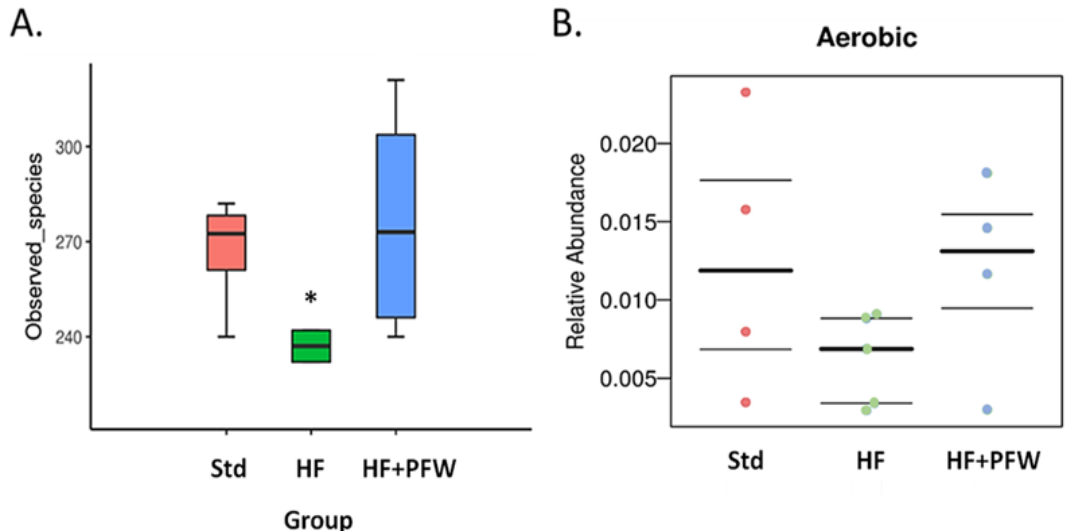
Figure 5. The effect of PFW on gut microbiota composition in high-fat diet-induced mice. ( A ) Alpha diversity index of the gut microbiota. ( B ) Relative abundance of aerobic bacteria. * p < 0.05 compared with the Std group. Group Std, standard diet; group HF, high-fat diet; group HF+PFW, high-fat diet plus PFW treatment.